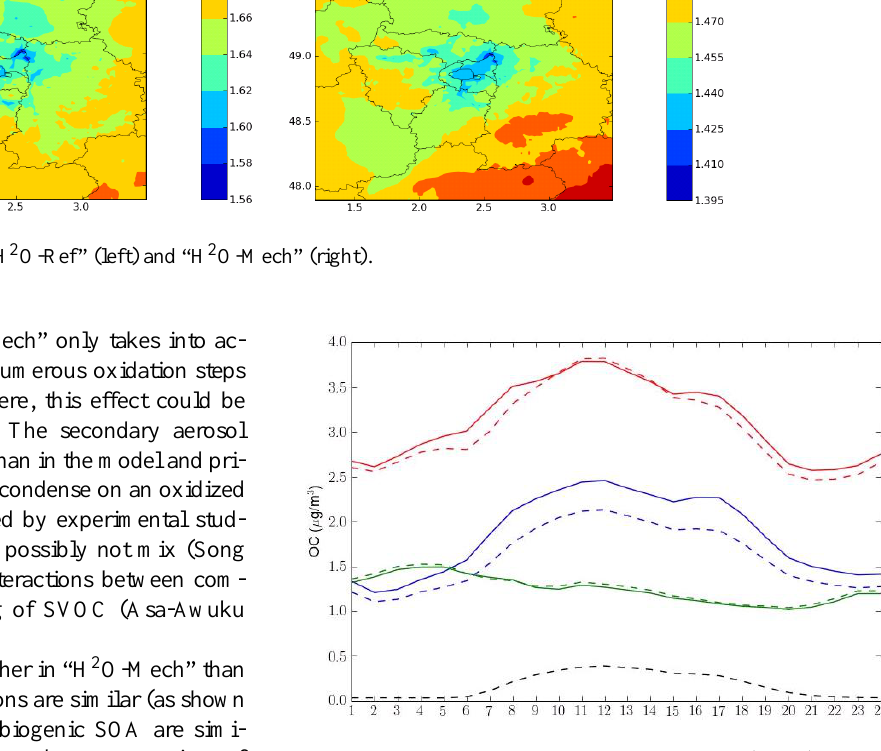
Fig. 11. Modeled temporal profiles of total SOA (in red), of SOA from primary SVOC oxidation (in blue), of biogenic SOA (in green), and of SOA from IVOC oxidation -in black) for “H 2 O-Ref” (solid lines) and for “H 2 O-Mech” (dashed lines)